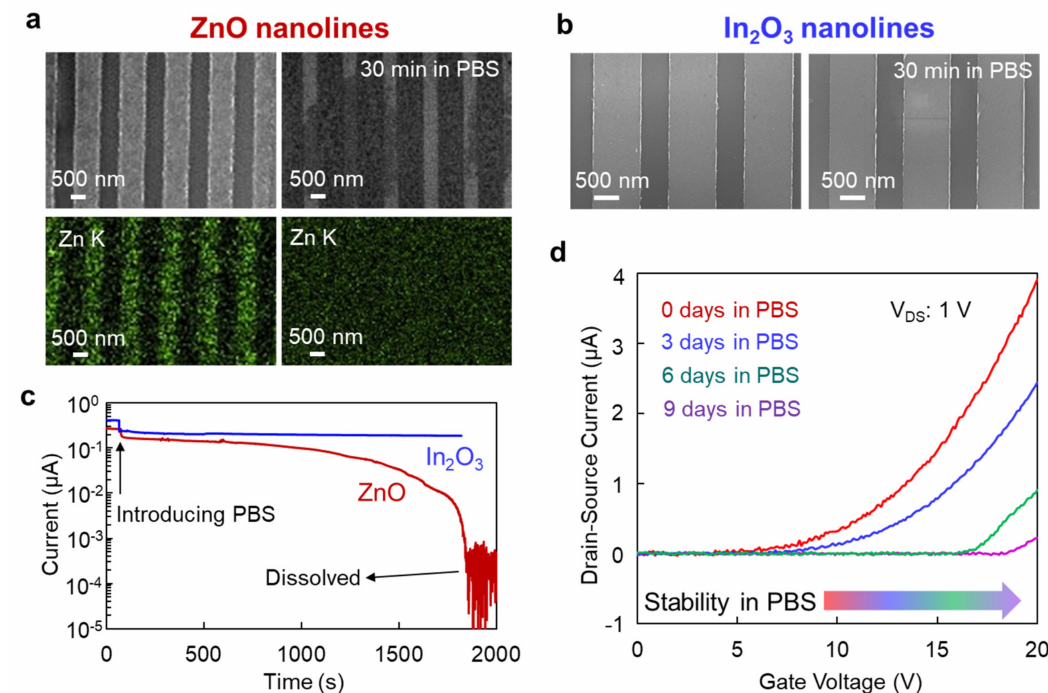
Figure 3. ( a ) FESEM images and EDS elemental mapping images of ZnO lines before and after soaking in PBS solution for 30 min. ( b ) FESEM images of In 2 O 3 nanolines before and after soaking in PBS solution for 30 min. ( c ) Time dependence of electrical conductance of In 2 O 3 and ZnO nanolines when soaked in PBS solution. ( d ) Transfer curves of the In 2 O 3 FET sensing device for different soaking times in PBS. Drain-source voltage was 1